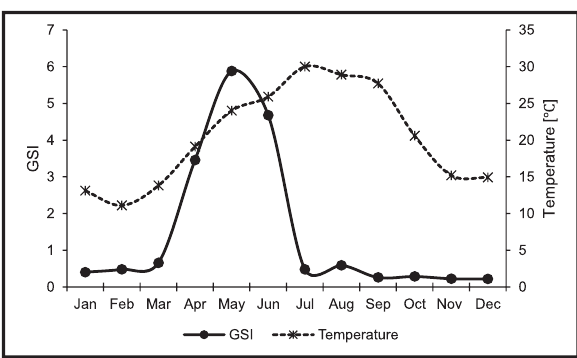
Fig. 4. Monthly variation of the gonadosomatic index (GSI) for female sand steenbras and water temperature in Köyceğiz